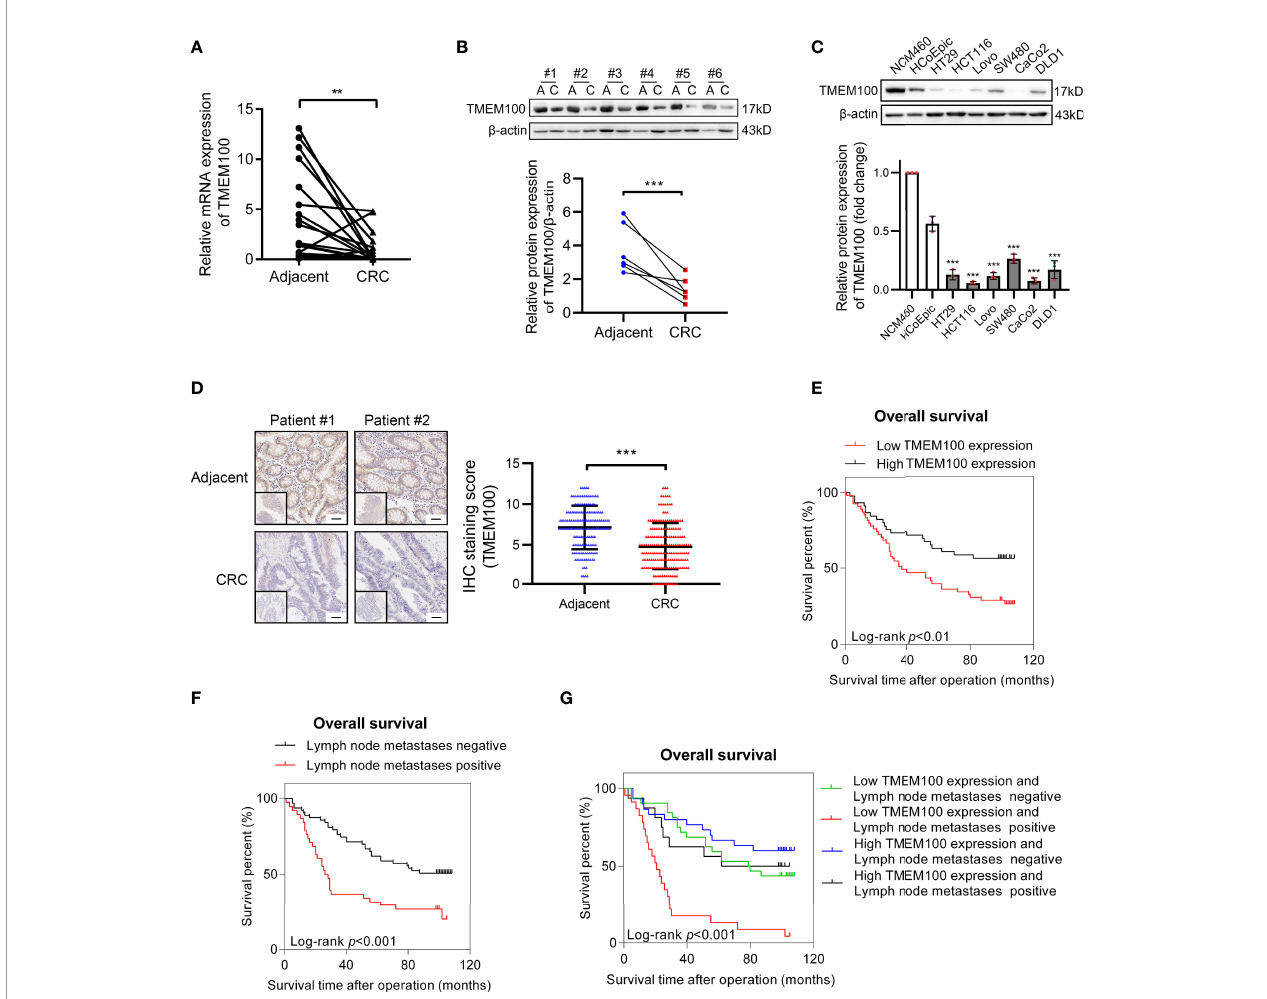
FIGURE 1 | TMEM100 is downregulated in CRC tissues and reduced TMEM100 expression indicated detrimental prognosis. (A) Relative mRNA expression level of TMEM100 in 23 CRC tissues and paired adjacent tissues was evaluated by RT-qPCR. Two-sided t-test. (B) Western blotting analysis of TMEM100 in 6 paired adjacent tissues and CRC tissues. b -actin was used as a reference control. Two-sided paired t-test. (C) Western blotting analysis of TMEM100 level in six human CRC cell lines and two human normal intestinal epithelial cell lines (*** p < 0.001 vs NCM460). b -actin was used as a reference control. Two-sided t-test. (D) Representative images of IHC staining of TMEM100 in 186 CRC tissues and 164 adjacent tissues in the tissue microarray. Scale bar = 50 m m. Two-sided t-test. (E, F, G) Overall survival was de fi ned as the interval between the date of surgery and the date of death or last follow-up. The CRC patients (n=101) with lower TMEM100 level indicated detrimental prognosis (E) . The CRC patients (n=101) with positive regional lymph node metastasis indicated detrimental prognosis (F) . The CRC patients (n=101) with both lower TMEM100 level and positive regional lymph node metastasis indicated worse prognosis (G) . Data are presented as the mean ± SD. ** p <0.01, *** p